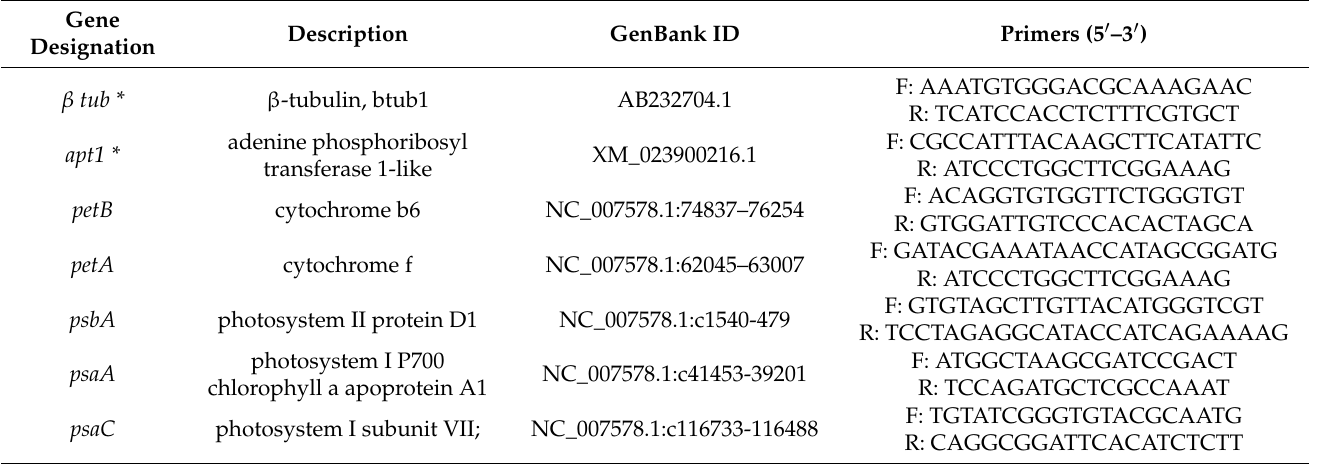
Table 1. Primers used for gene expression